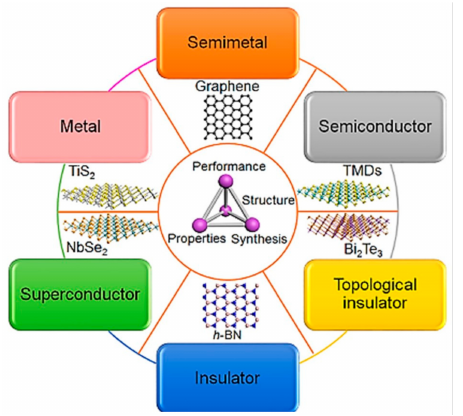
Figure 3. 2D material family (Reprinted from [24], with the permission of AIP